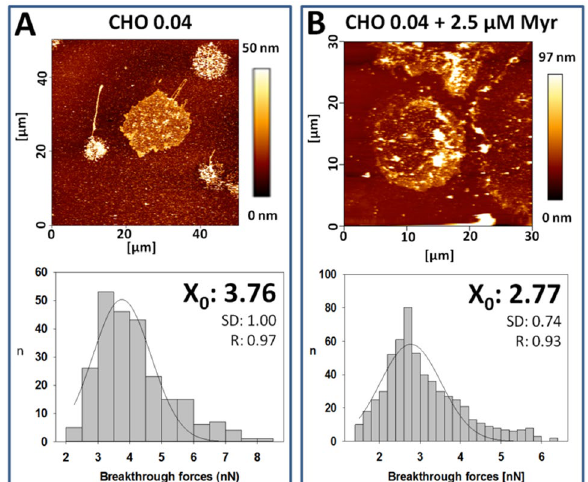
Figure 6. Topographic image and breakthrough force distributions of PM patches. PM patches from non- treated ( A ) and myriocin-treated ( B ) CHO cells grown in deficient medium. Three independent experiments were performed; n = 150–170 (50–60 breakthrough forces × 3 replicas. Statistical significance was calculated with the Student´s t-test, P =